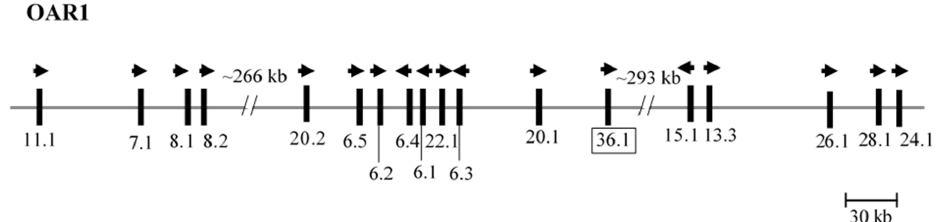
Figure 1. KRTAPs identified on the sheep chromosome 1 region that contains a newly identified KRTAP36-1 . The newly identified gene is shown in a box, and the 17 previously identified KRTAPs are also shown. Vertical bars represent the location of different KRTAPs and the arrowheads indicate the direction of transcription. The numbers below the bars indicate the name of the respective KAP genes (i.e., 11.1 is KRTAP11-1 ). The nucleotide distances are approximately and refer to NC_019458.2.